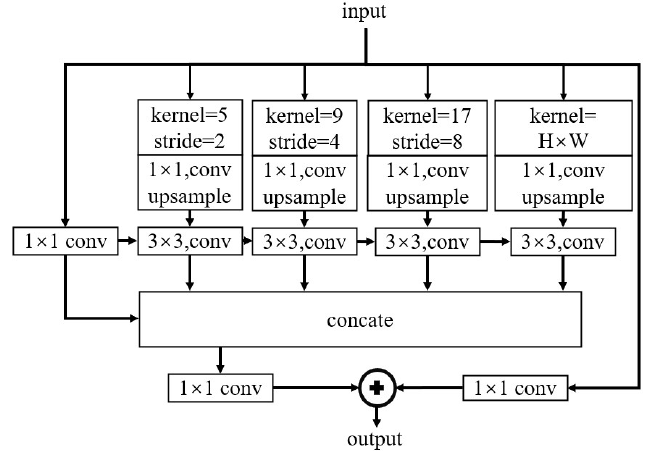
Figure 4. Structure of